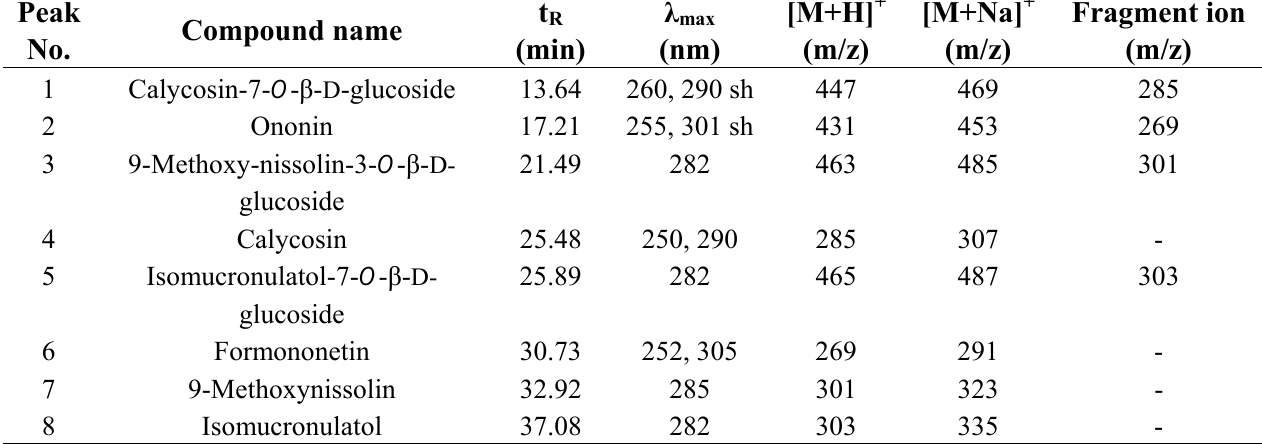
, UV λ , [M+H] + and [M+Na] + of flavonoid standard R max